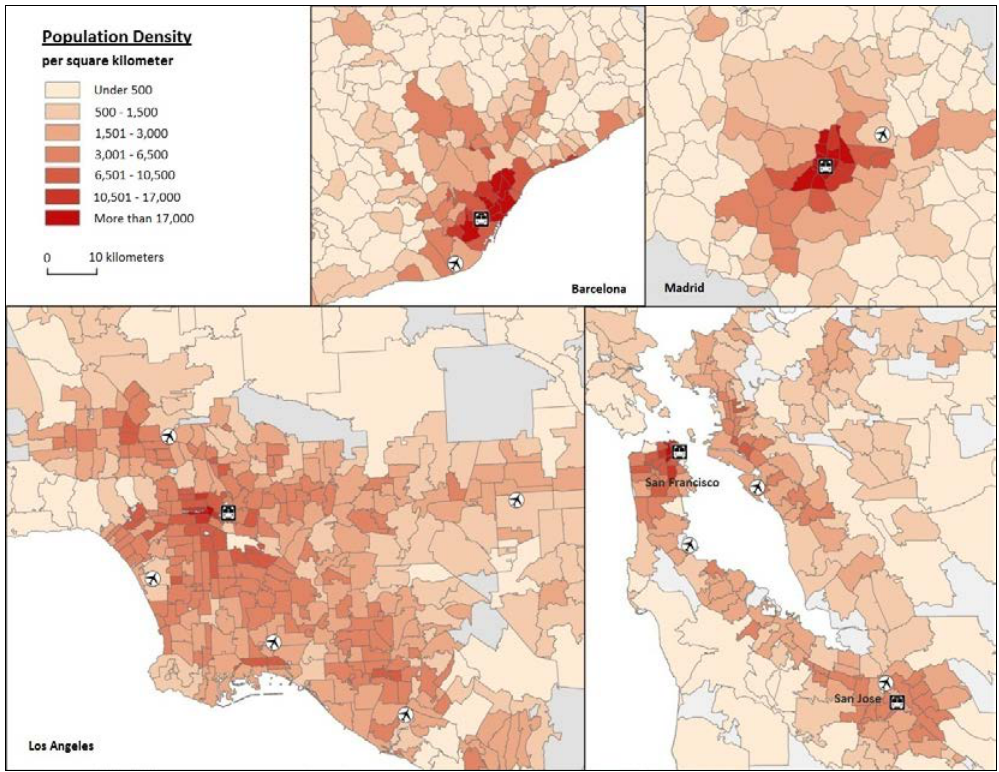
Figure 1 Population Density Comparisons: Barcelona, Madrid, Los Angeles and San Francisco Bay Area